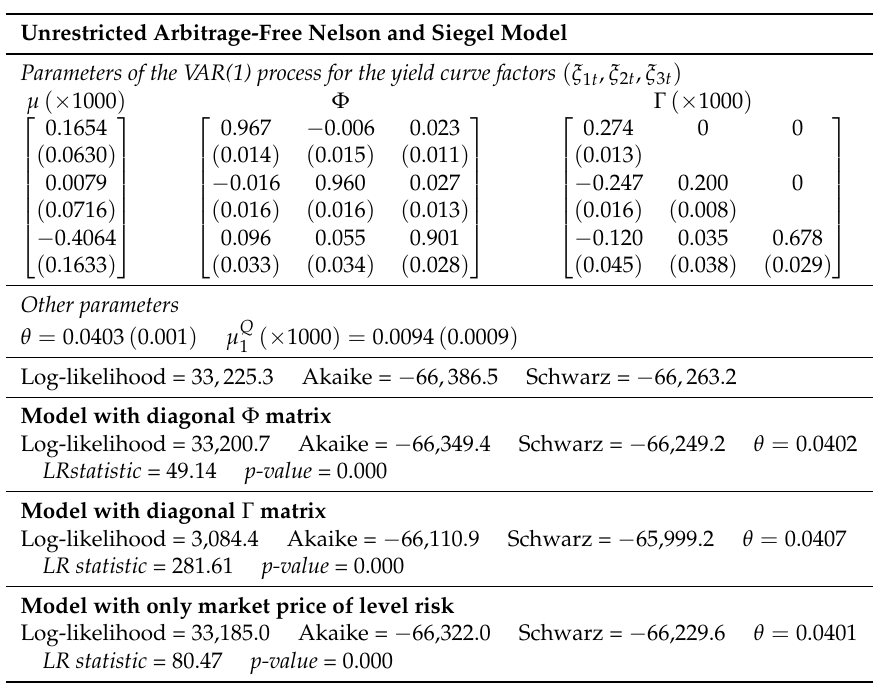
Table 1. Estimates of arbitrage-free Nelson and Siegel models.